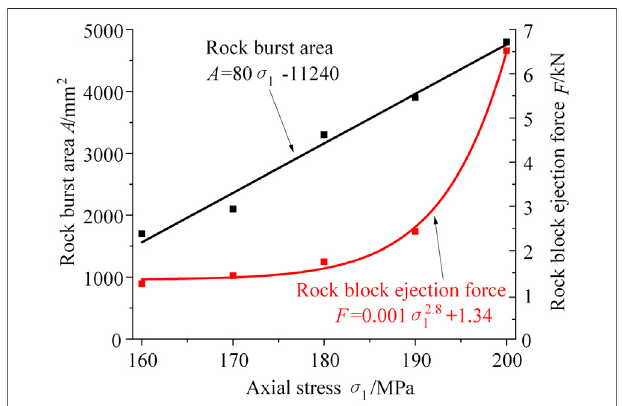
FIGURE 12 | Relationship among the rock burst area, rock block ejection force, and axial stress.